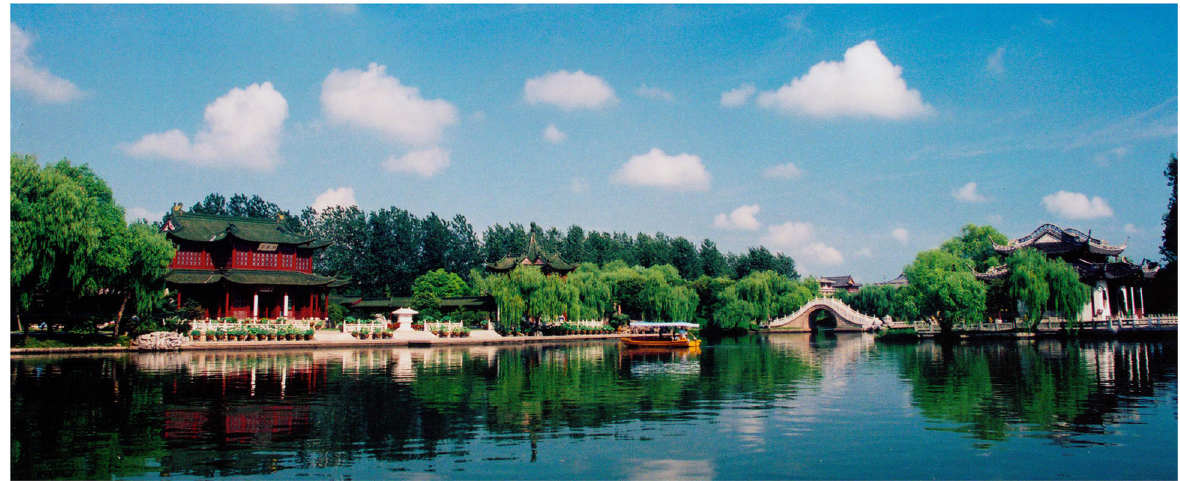
Fig. 2 Slender West Lake Scenic Area in summer (Source: Songsong Shen,